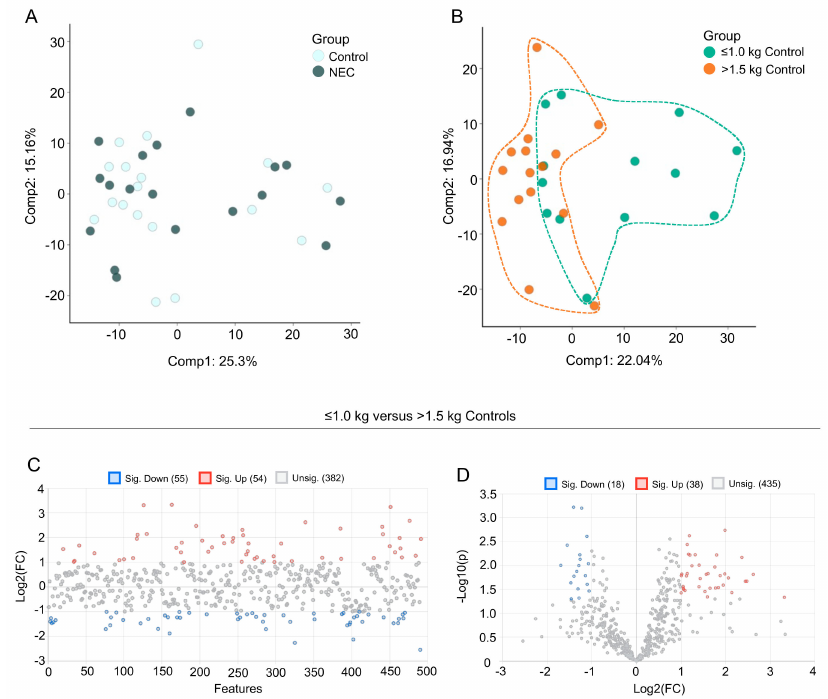
Figure 1. Principal component analysis (PCA) and fold change analysis of human milk samples. PCA of the data reveals ( A ) segregation of breast milk samples from mothers of control infants and infants with NEC and ( B ) segregation of breast milk samples from mothers of control infants with birth weight ≤ 1.0 kg compared with birth weight >1.5 kg. ( C ) Fold change analysis of the absolute value of change between the ≤ 1.0 kg versus >1.5 kg birth weight control groups using a fold change threshold of 2.0. ( D ) Volcano plot analysis of ≤ 1.0 kg versus >1.5 kg birth weight control groups using a fold change threshold of 2.0 and p <